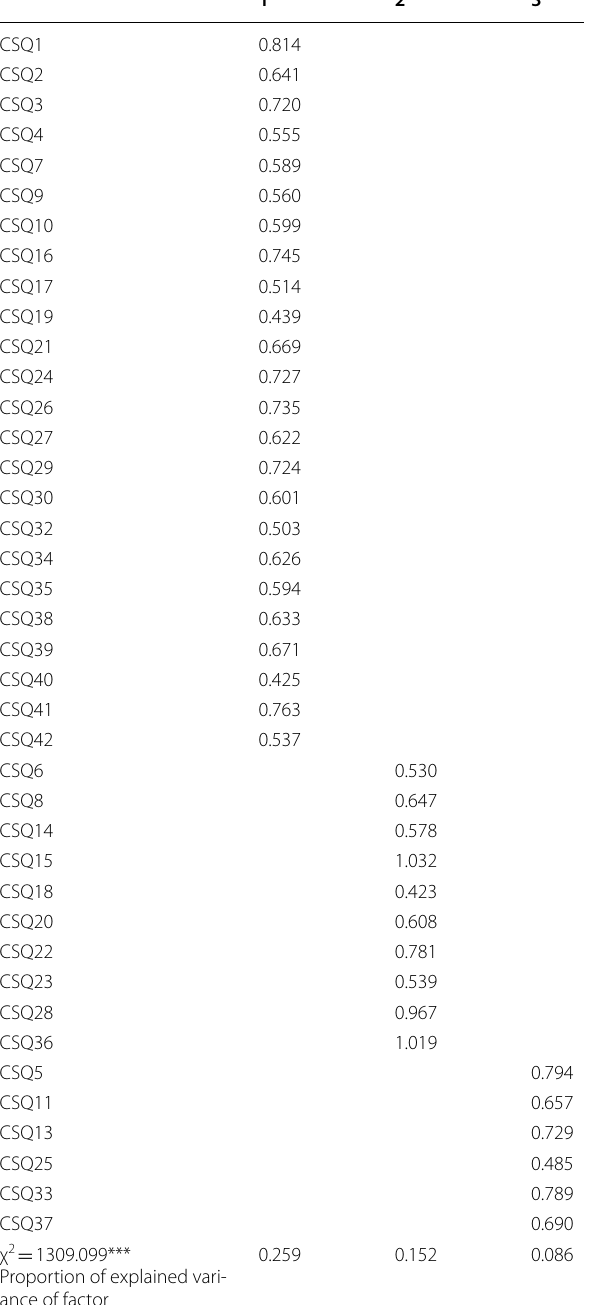
Table 5 Exploratory factor analysis of the Igbo‑CSQ using the parallel analysis to determine dimensionality